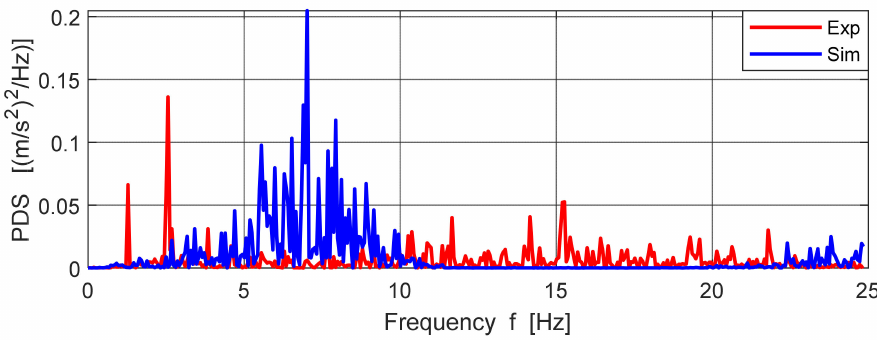
Figure 23. PSD of vertical accelerations on vehicle FA, 0–25